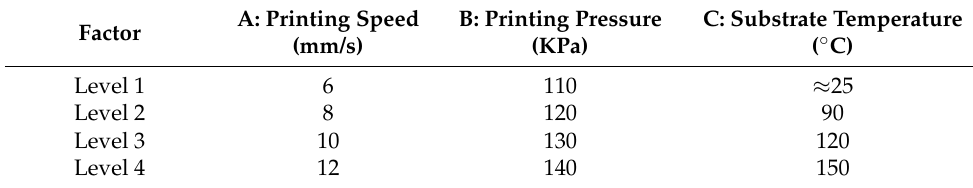
Table 2. Factor-level table selected in the orthogonal experiment.